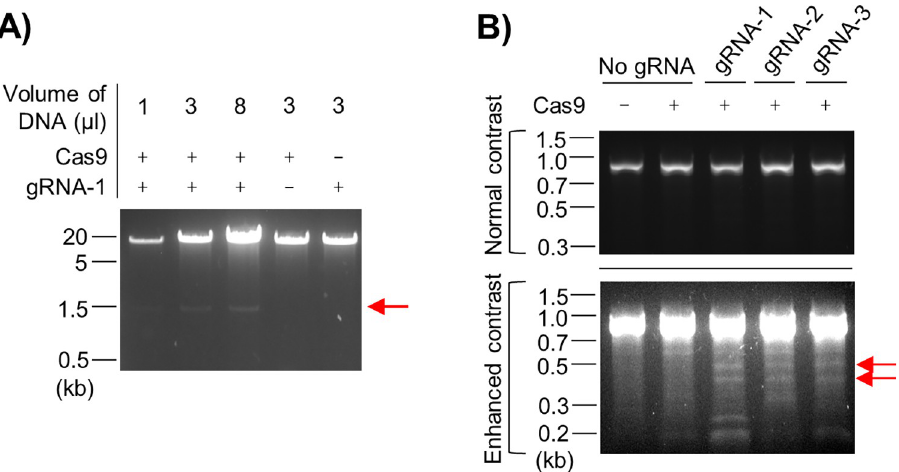
Fig 2. Selected Prnp gRNAs induce Cas9-mediated cleavage within the Prnp ORF. (A) Agarose gel image showing that recCas9 cleaves a half-genomic Prnp expression construct (MoPrP. Xho .wt) when Prnp gRNA–1 is present. A cleavage product of the expected size is indicated by the red arrow. (B) Agarose gel images showing the products of T7E1 mismatch cleavage assay reactions for DNA samples obtained from untransfected WT-5 RK13 cells (Cas9-negative) or cells transfected with eSpCas9(1.1) expression plasmids containing Prnp gRNA–1, –2 or –3, or no gRNA. In the absence of Prnp ORF disruptions, a PCR product of ~900 bp was expected. The faint bands appearing at ~400 and 500 bp only when Prnp gRNAs were expressed indicate that indels resulting from NHEJ events were present.